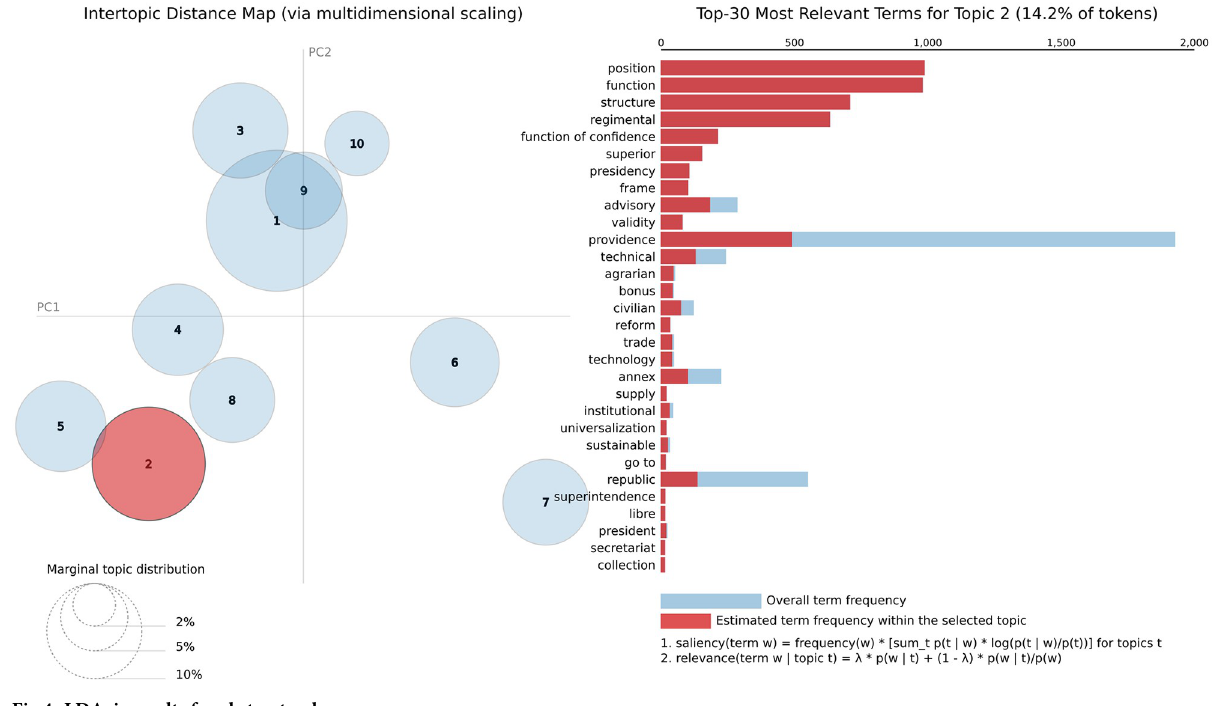
Fig 4. LDAvis results for abstract